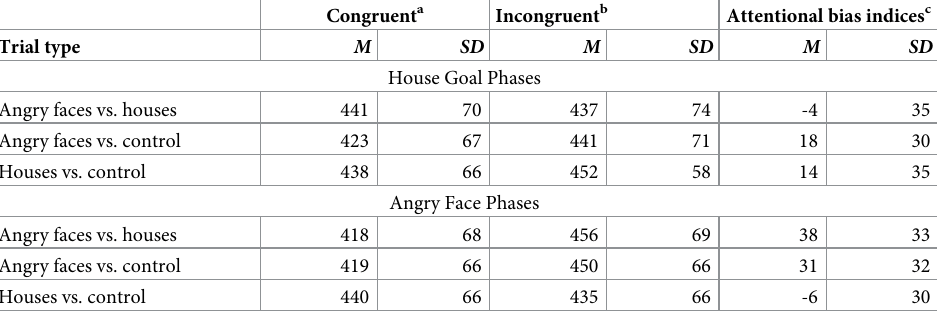
Table 1. Mean RTs and standard deviations (in ms) as a function of phase goal, trial type, and congruence.